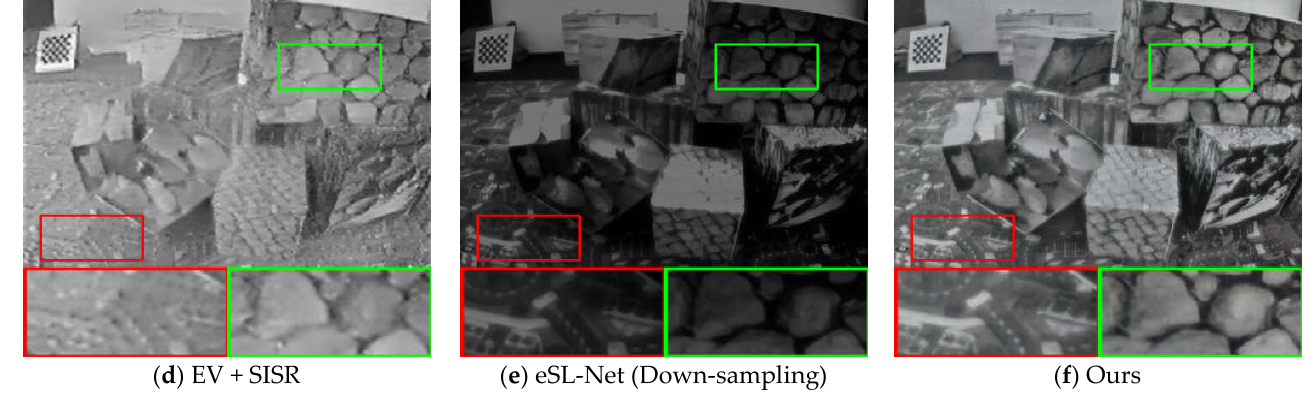
Figure 6. Comparison of the visual quality of our proposed method with other state-of-the-art methods for 2 × SR on real datasets. The APS frame is upsampled with bicubic interpolation to the corresponding scale for reference. The 4 × SR results of eSL-Net is downsampled with bicubic interpolation to the corresponding scale for reference.